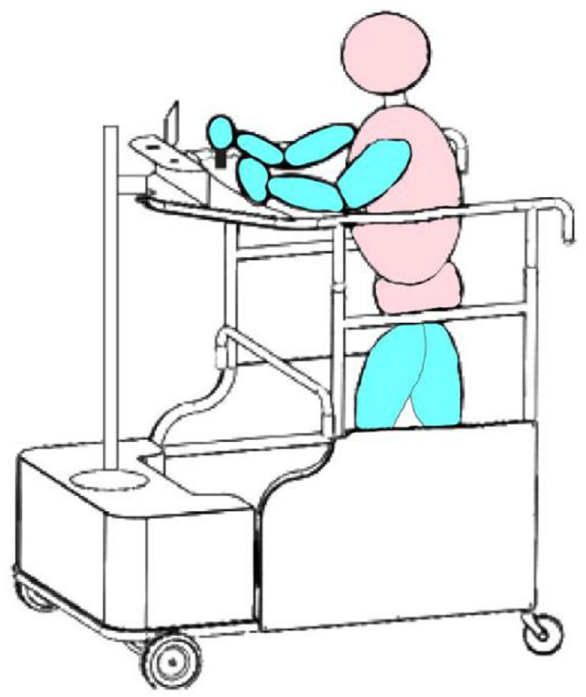
Figure 2: Normal walking pattern.